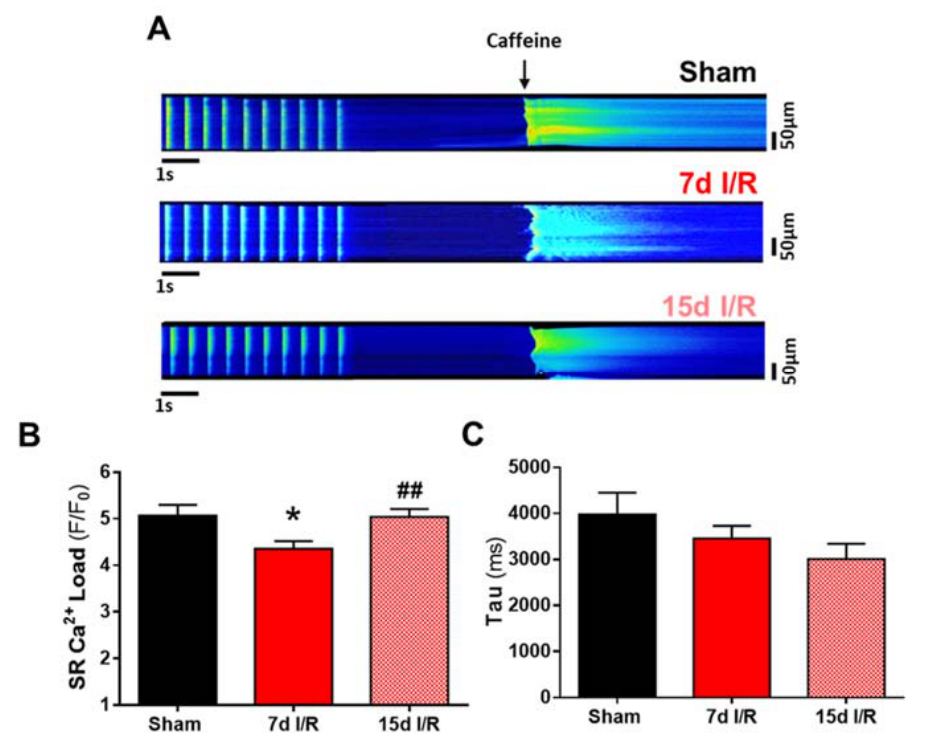
Figure 3. Sarcoplasmic reticulum Ca 2+ load analysis on electrically stimulated cardiomyocytes. ( A ) Representative line-scan images of caffeine-evoked Ca 2+ transients in cardiomyocytes from sham-treated mice and from mice subjected to ischemia and reperfusion (I/R) for 7 and 15 days. Cardiomyocytes were electrically stimulated at 2 Hz. ( B ) Mean values of the transient amplitude evoked by caffeine (peak fluorescence calcium, F/F 0 ) in stimulated cardiomyocytes. ( C ) Decay time constant, Tau, in milliseconds. Data are expressed as mean ± SEM. * p < 0.05 versus sham, ## p < 0.01 versus 7 d I/R; sham ( n = 37 cells, N = 10 mice), 7 d I/R ( n = 59 cells, N = 10 mice), and 15 d I/R ( n = 73 cells, N = 6 mice).